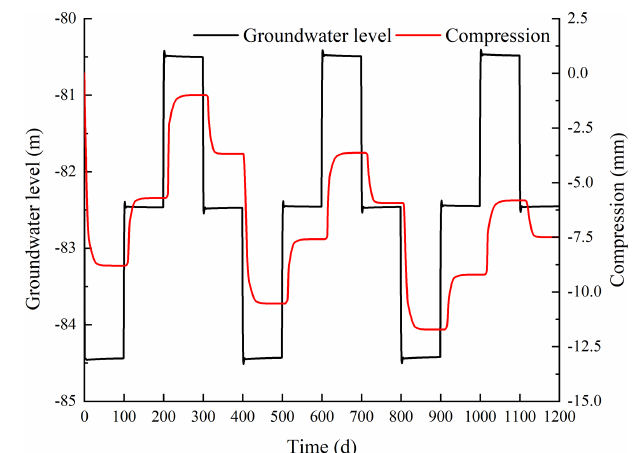
Figure 5. Compressed volume and water level with stress period in the fourth confined aquifer group under the second pumping and recharge scheme.